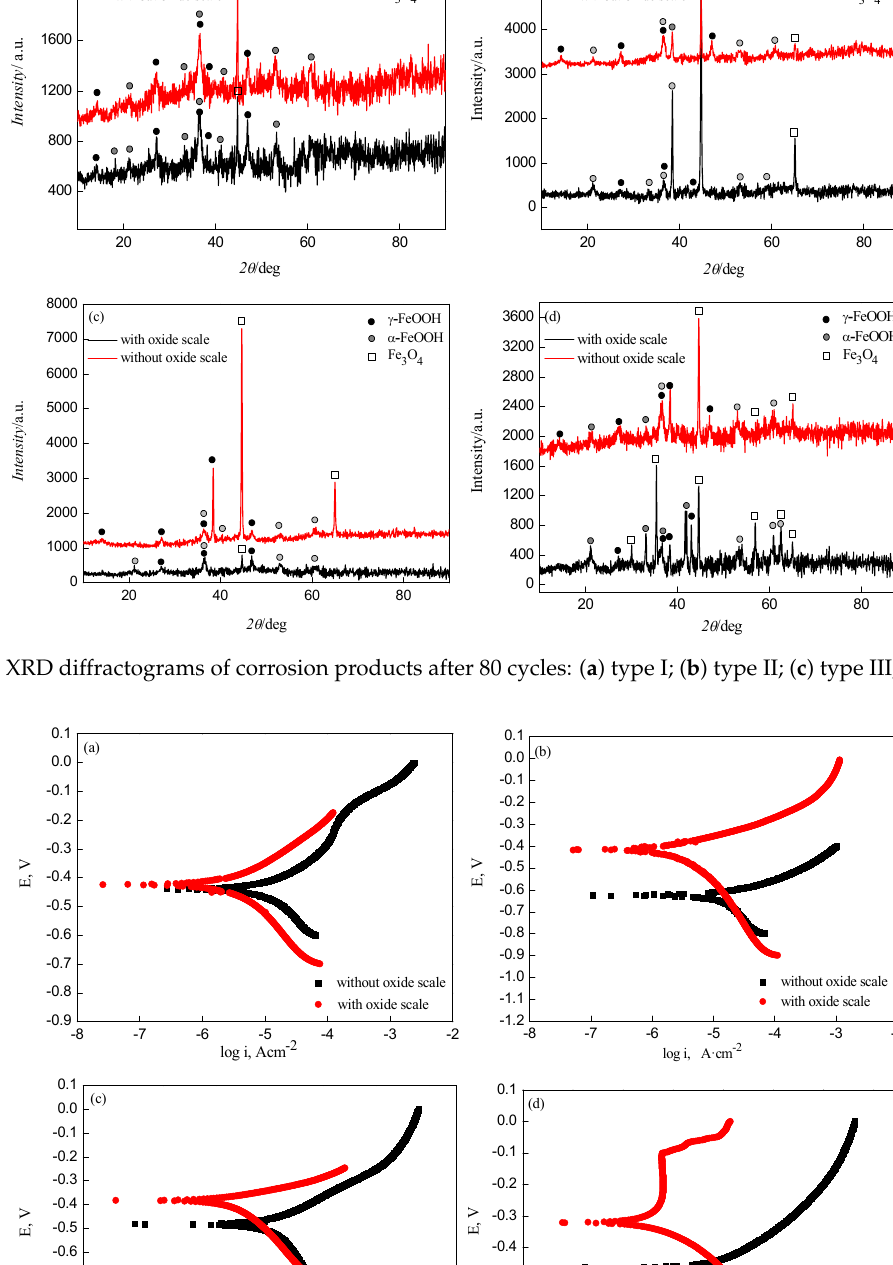
Figure 7. XRD diffractograms of corrosion products after 80 cycles: ( a ) type I ; ( b ) type II; ( c ) type III; ( d ) type IV.